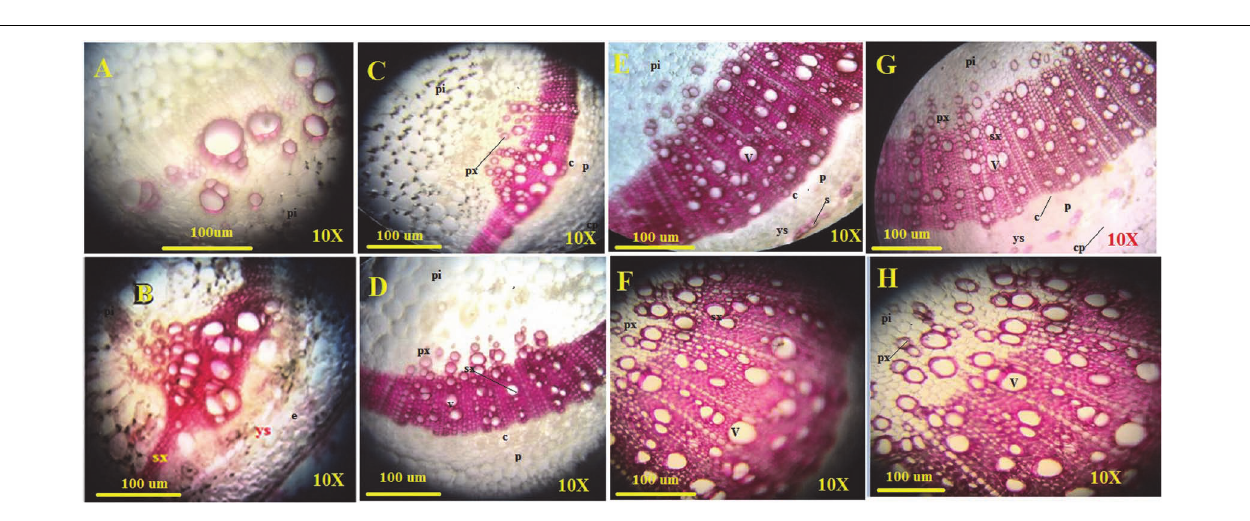
Frontiers in Plant Science |